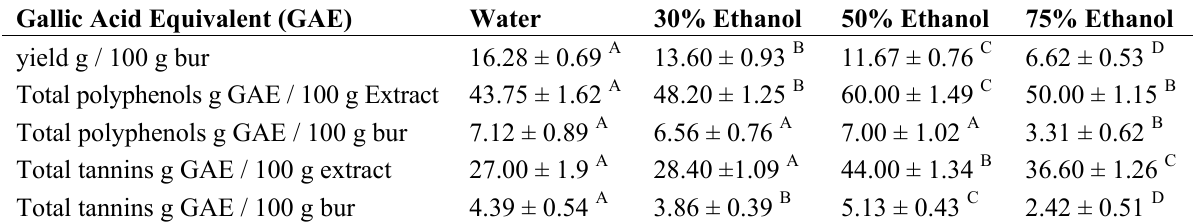
Table 1. Extracting yield and total polyphenols and tannins contents in chestnut burs extract. Gallic Acid Equivalent (GAE) Water 30% Ethanol 50% Ethanol 75% Ethanol yield g / 100 g bur 16.28 ± 0.69 A Total polyphenols g GAE / 100 g